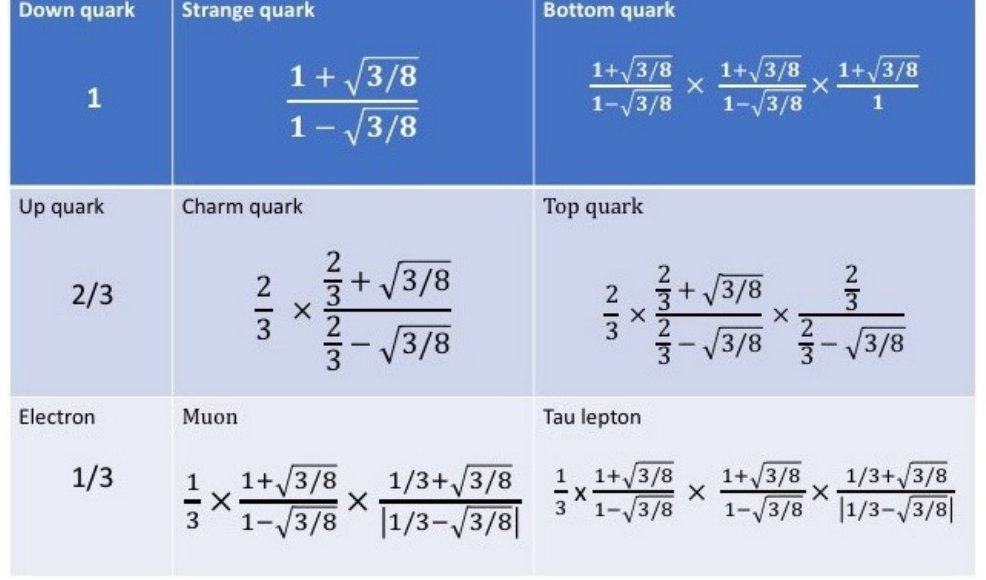
Figure 2. Square-root mass ratios of charged elementary fermions